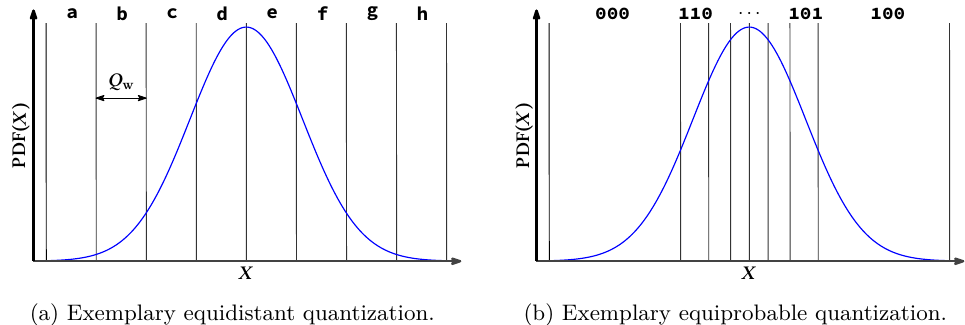
Figure 9: Different quantization approaches with assignment of symbols for the equidistant quantization and a Gray code in case of equiprobable